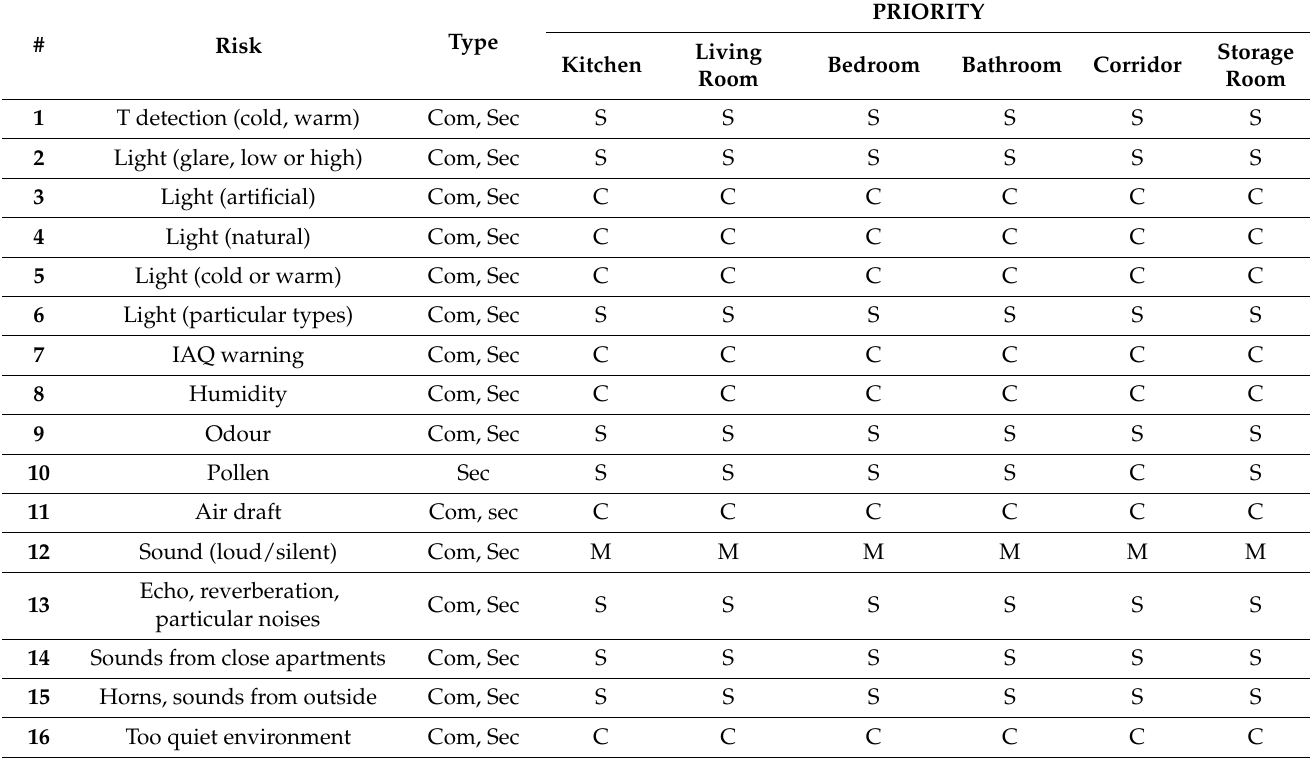
Table A1. Priority MoSCoW scale associated with the environmental